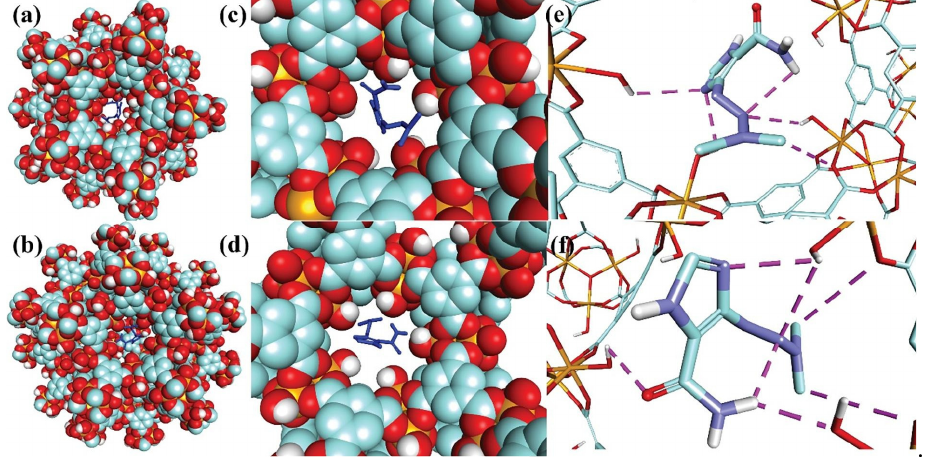
Figure 7. Schematic representation of the molecular docking of MIL-100(Fe) small ( a , c , e ) and big ( b , d , f ) cages with DTIC. ( a , b ) Full view from outside. ( c , d ) View from inside the cage. ( d , f ) Hydrogen bonds between DTIC and pentagonal window. Fe, C, O, and H colors are orange, green, red, and white in cage structures, respectively. The purple line in ( c ) indicates hydrogen bonding [66].